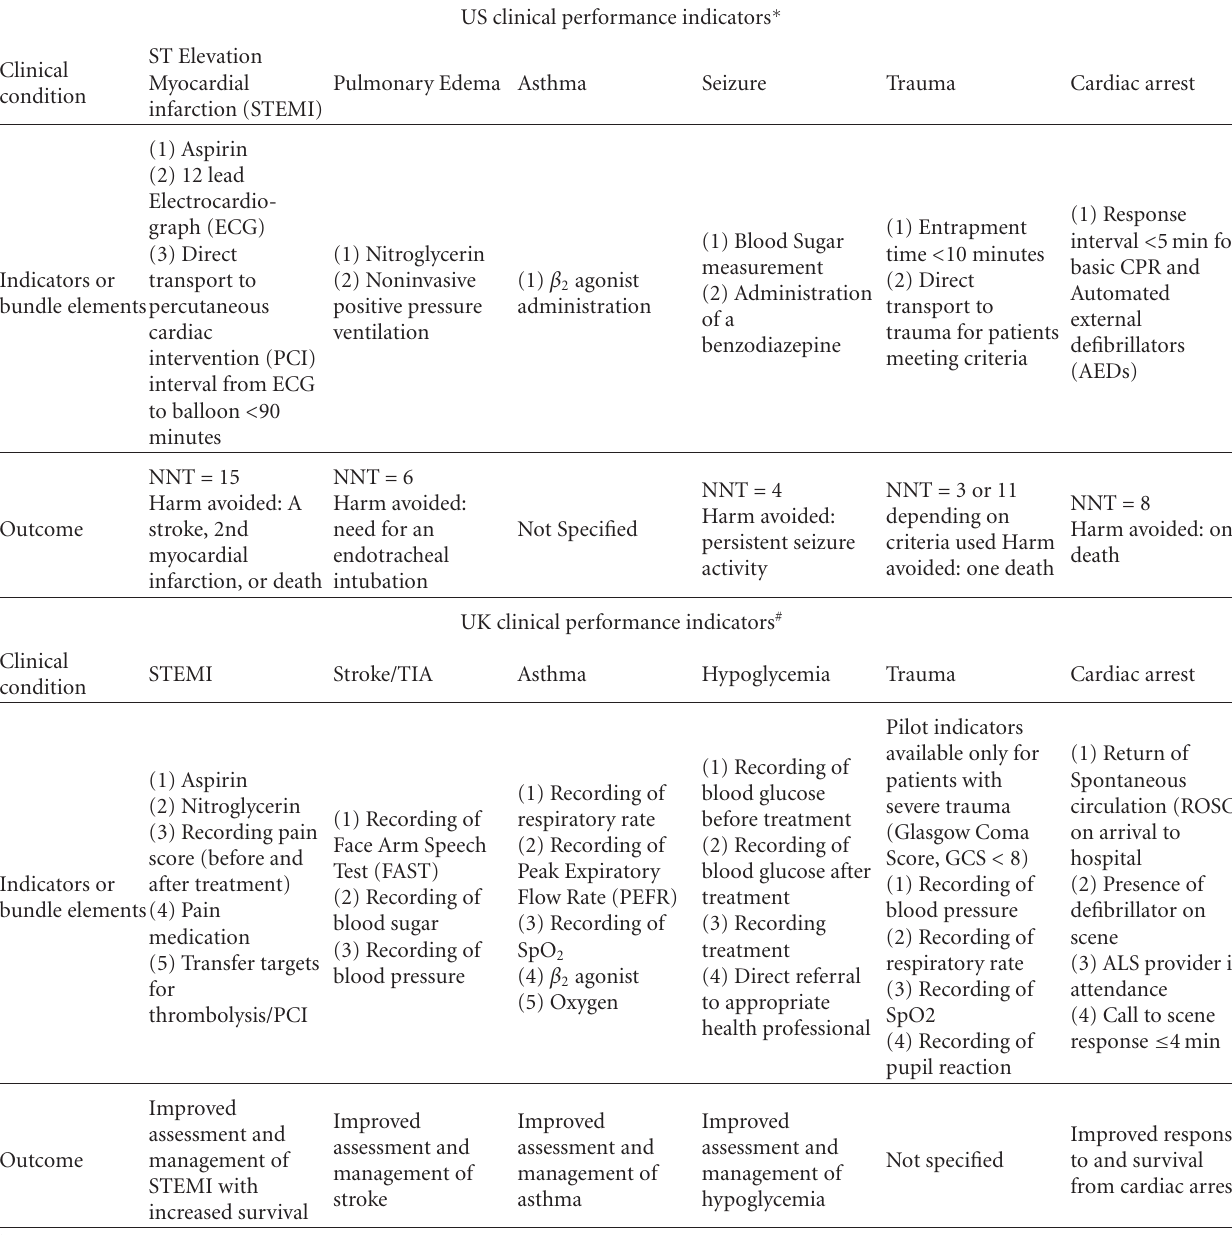
Table 2: Comparison of EMS clinical performance indicators. US clinical performance indicators